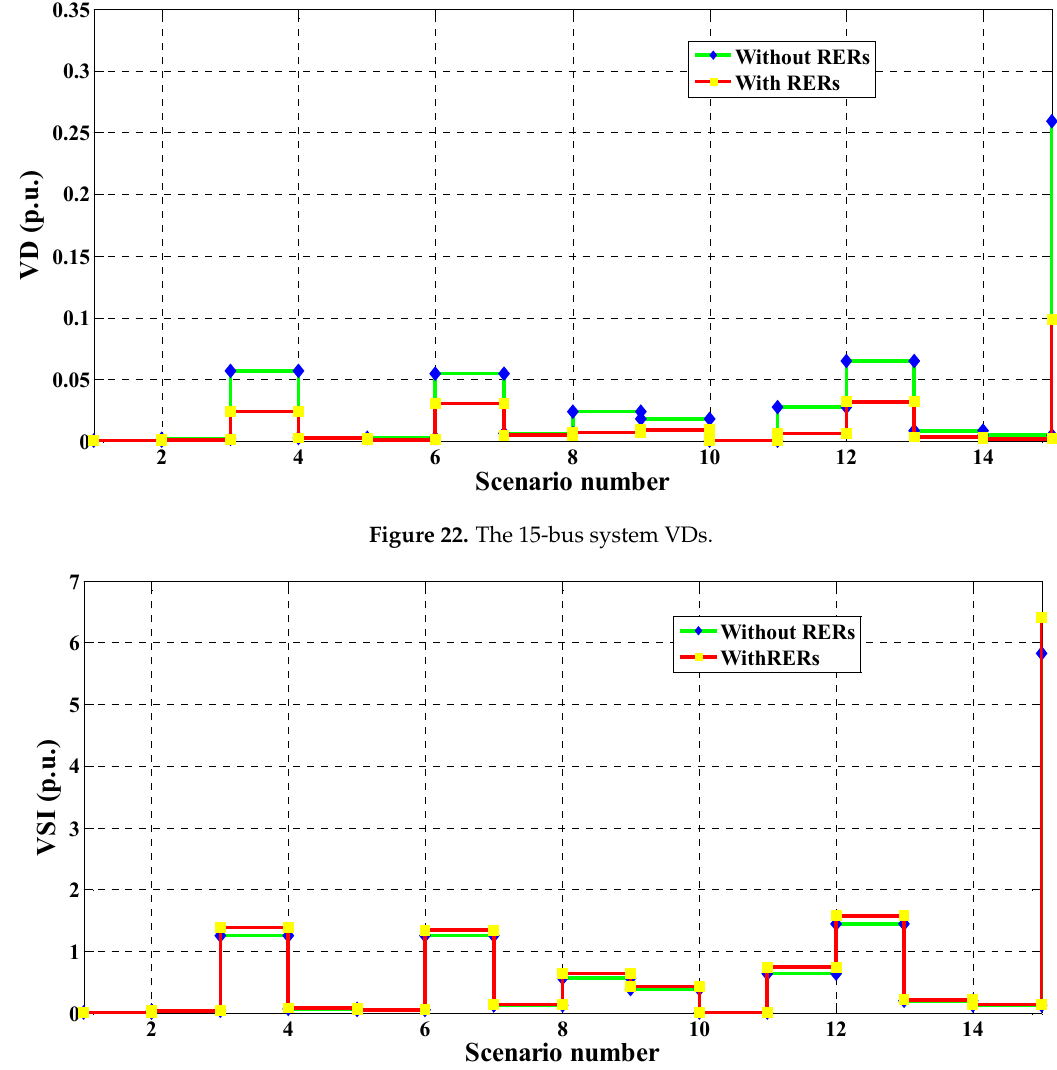
Figure 23. The 15-bus system VSIs.